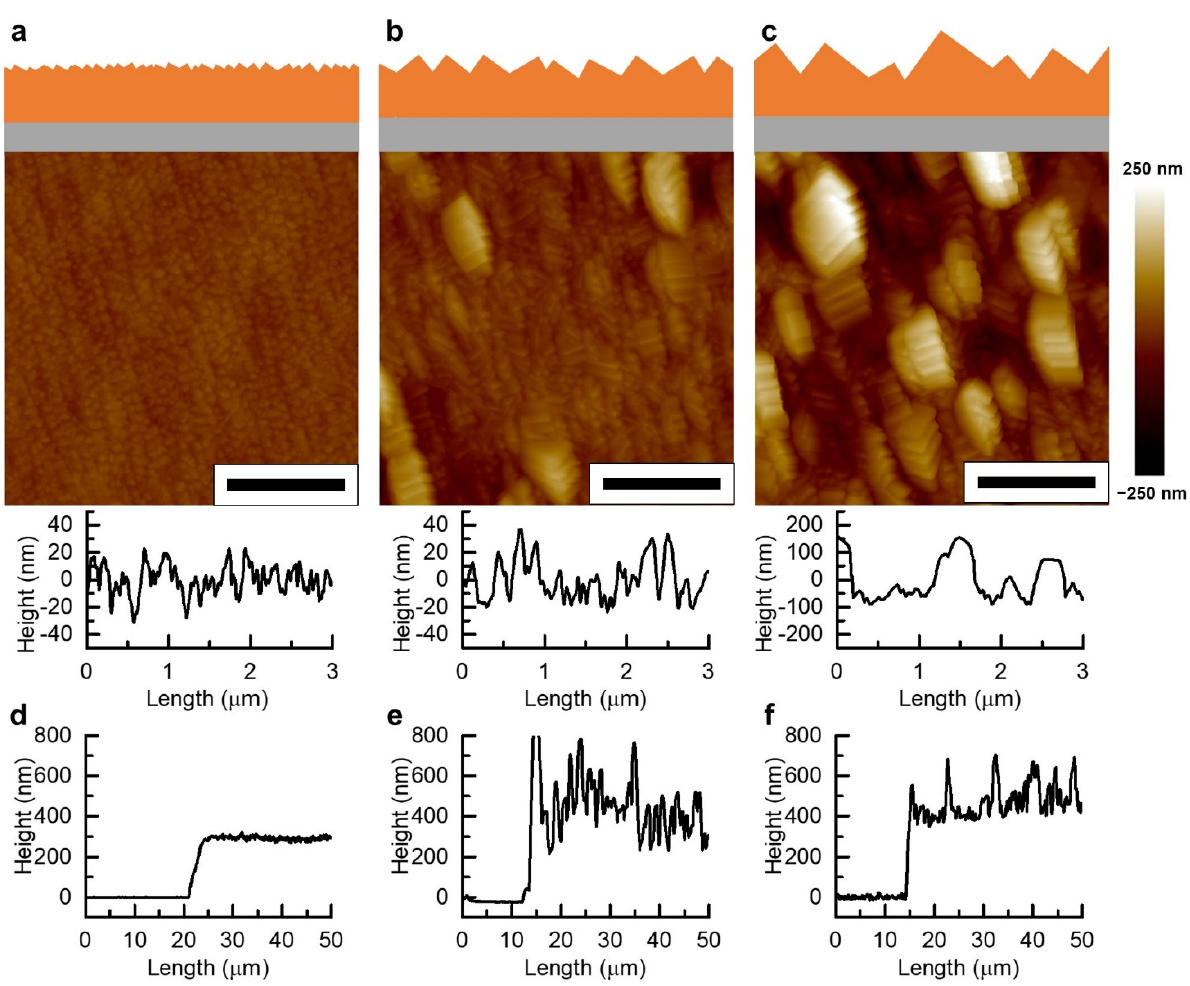
Figure 2. AFM images of CuHCFe thin films grown at ( a ) 5, ( b ) 25, and ( c ) 60 °C. Line profiles of the step edge of CuHCFe thin film grown at ( d ) 5, ( e ) 25, and ( f ) 60 °C. Scale bar: 1 μ m.